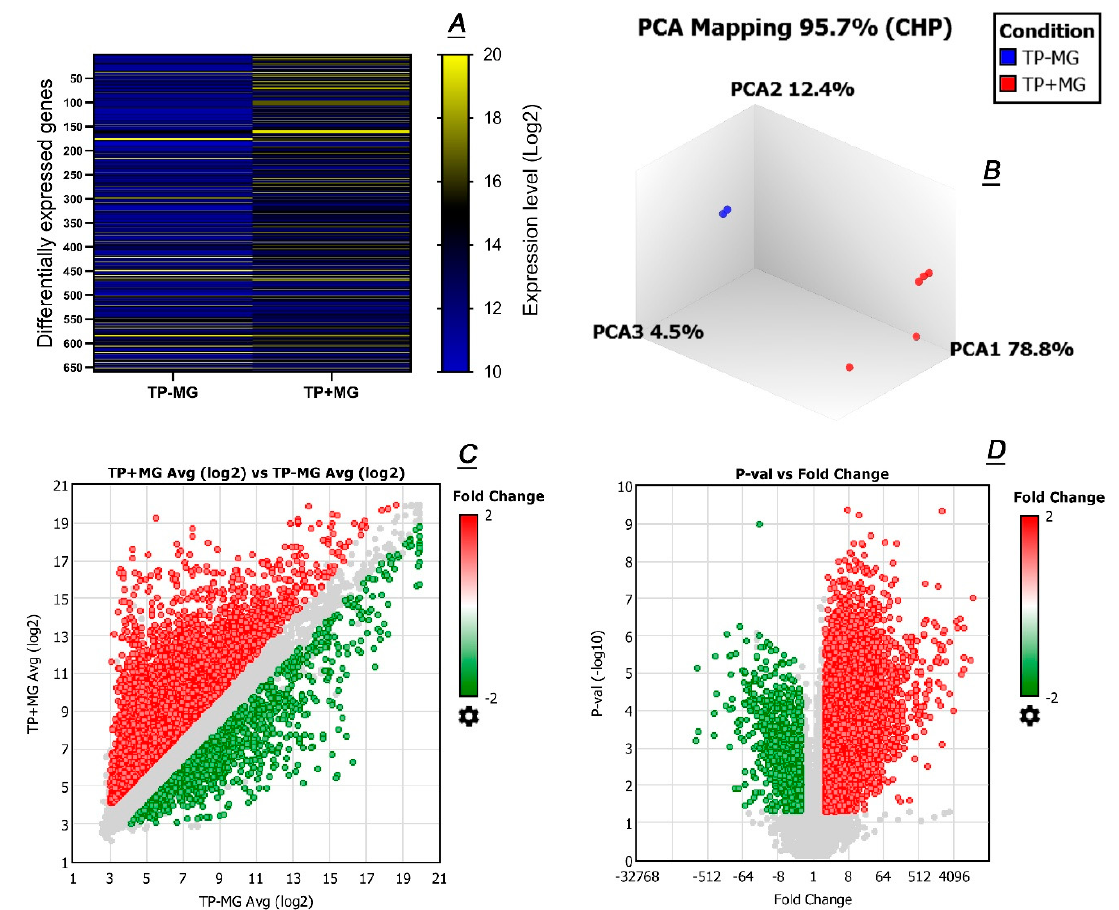
Figure 6. Comparative transcriptomic analyses of human tarsal plates with and without embedded Meibomian glands. ( A ) Averaged heat maps of 650 di ff erentially expressed genes (LFC ≥ ( + 10) or ≤ ( − 10)) in male tarsal plates without (TP − MG; n = 2) and with (TP + MG; n = 5) Meibomian glands. ( B ) Principal component analysis of (TP − MG) and (TP + MG) samples revealed clear grouping of genes based on the types of the specimens. PCA1 was the major contributor to the e ff ect. ( C ) A Log2 scatter plot of all genes detected in (TP − MG) and (TP + MG) samples illustrates extremely high di ff erences between the two groups of samples. ( D ) A “volcano” plot of averaged (TP − MG) and (TP + MG) samples. The di ff erences between the samples were found to be highly significant.